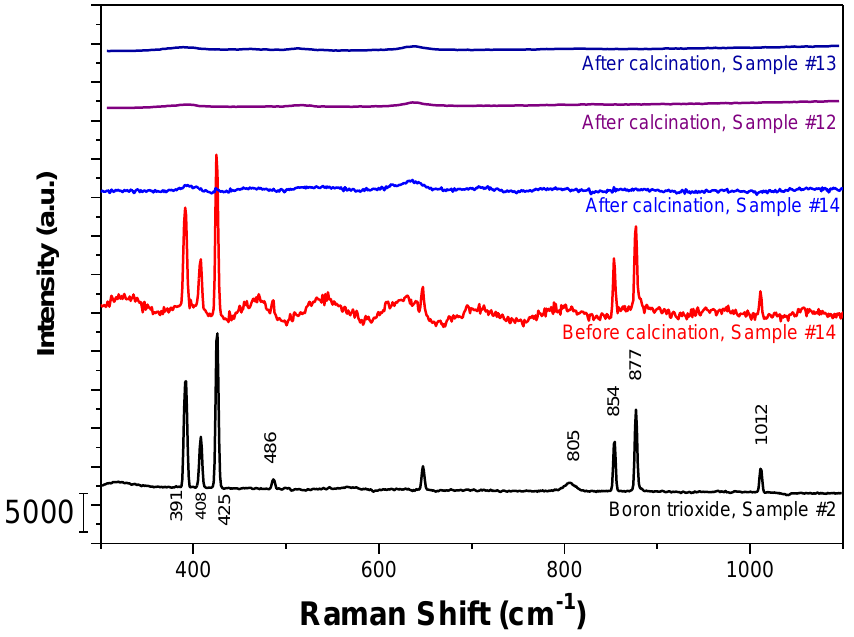
Figure 6. Raman spectra collected for FCC additive samples (#12 and #13) using a 488-nm laser and an FCC catalyst sample #14 using a 785-nm laser before (the 4 th trace from top) and after (the 1 st , 2 nd and 3 rd traces from top) calcination with comparison to pure boron trioxide (bottom trace) reference show that boron trioxide phase disappears after calcination. The top three spectra were normalized based on the peak intensity at 635 cm −1 to the elemental content of TiO 2 in the two samples.